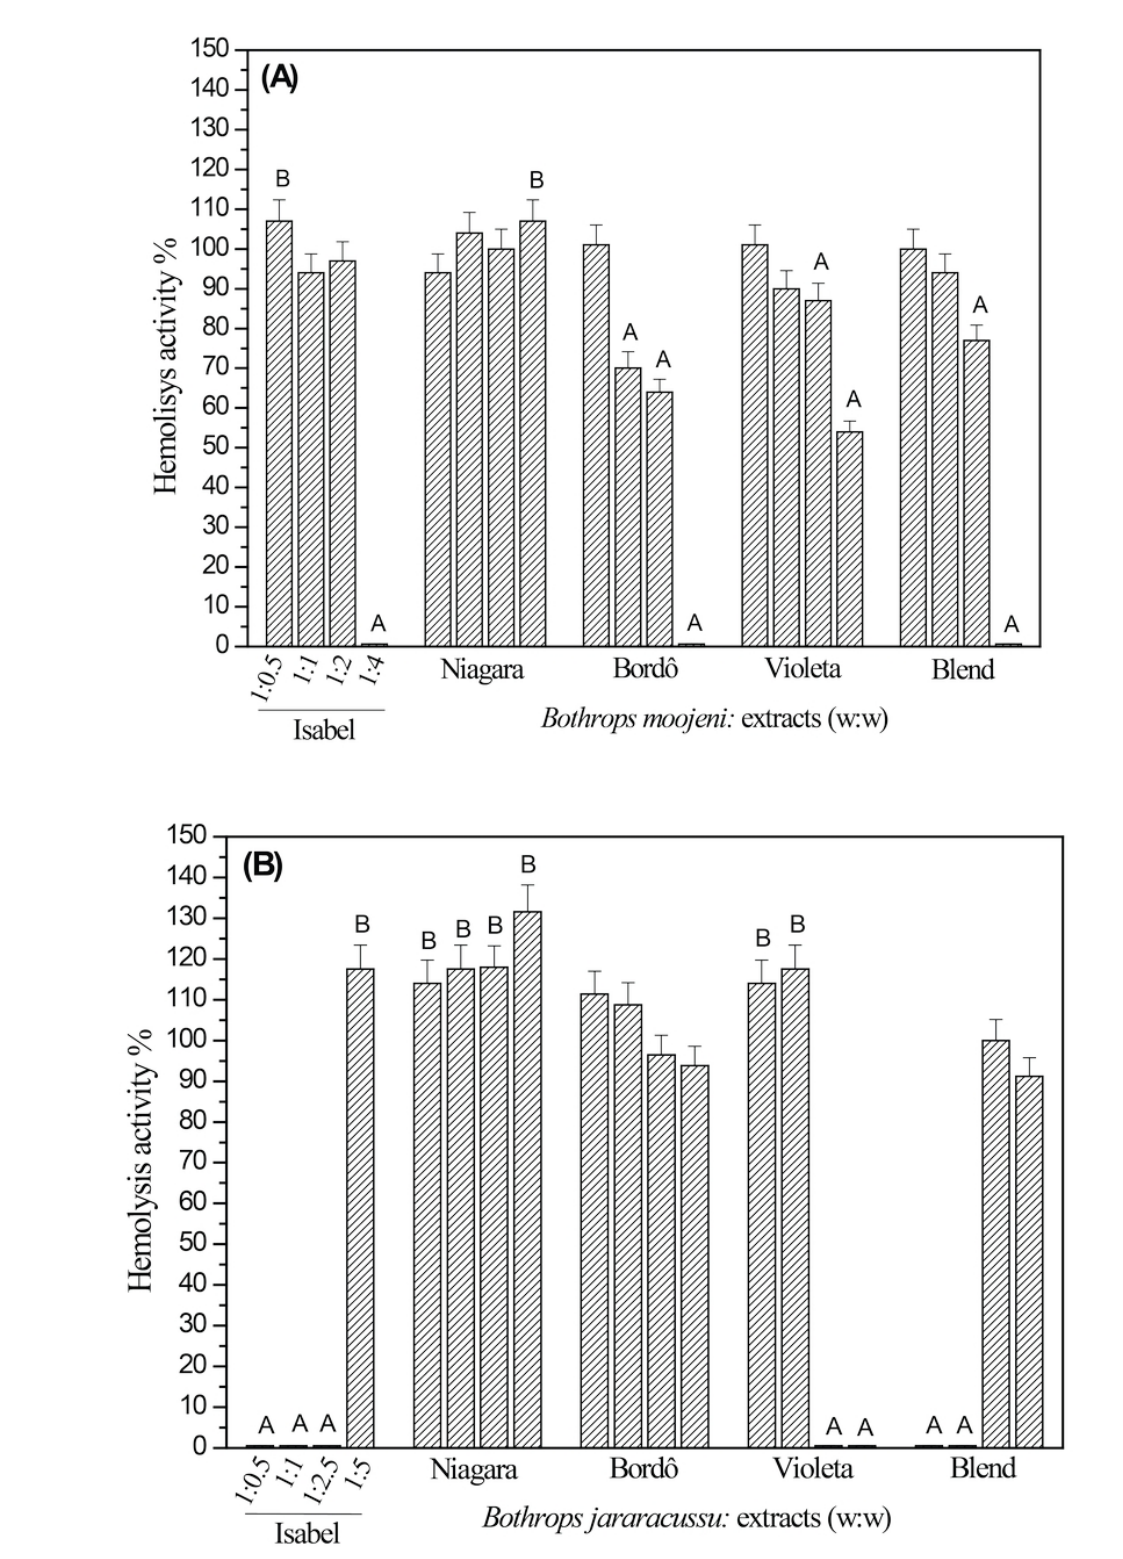
FIGURE 4 - Effect of dried grape pomace from different cultivars on venom-induced hemolytic activity of Bothrops moojeni (A) and B. jararacussu venoms (B). The data represent means and standard deviation of values obtained in three independent tests performed with samples evaluated in triplicate. Controls (+) containing only venom (30 μg) were considered as 100% activity. A = differs from the positive control in inhibition. B = differs from the positive control in